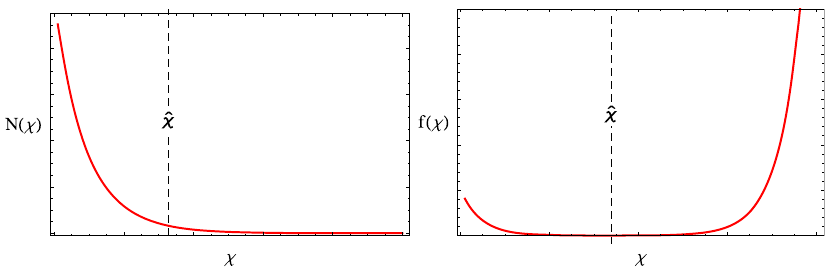
Fig. 2 Left panel: The lapse function N against the radial coordinate r , for points χ < ˆ χ (dashed black line). As can be seen, this function shows an asymptotically flat behavior N → 1 when r → +∞ . Middle panel: The lapse function N versus the radial coordinate r , for points